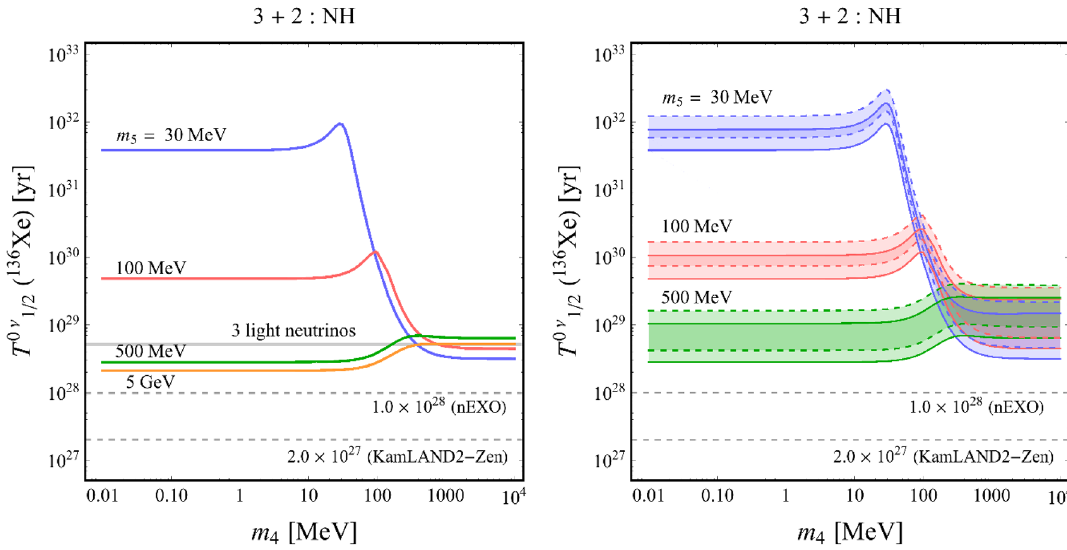
Figure 8 . Left panel: 0 (cid:23)(cid:12)(cid:12) half-life of 136 Xe as a function of m 4 for m 5 = 30 MeV (blue), m 5 = 100 MeV (red), m 5 = 500 MeV (green), and m 5 = 5000 MeV (orange) in the NH. The gray horizontal line is the predicted half life for the standard mechanism for the same choices of neutrino parameters and LECs. Right panel: same as left panel but now we included uncertainties from NMEs and LECs. Bands correspond to m 5 = 30 MeV (blue), m 5 = 100 MeV (red), m 5 = 500 MeV